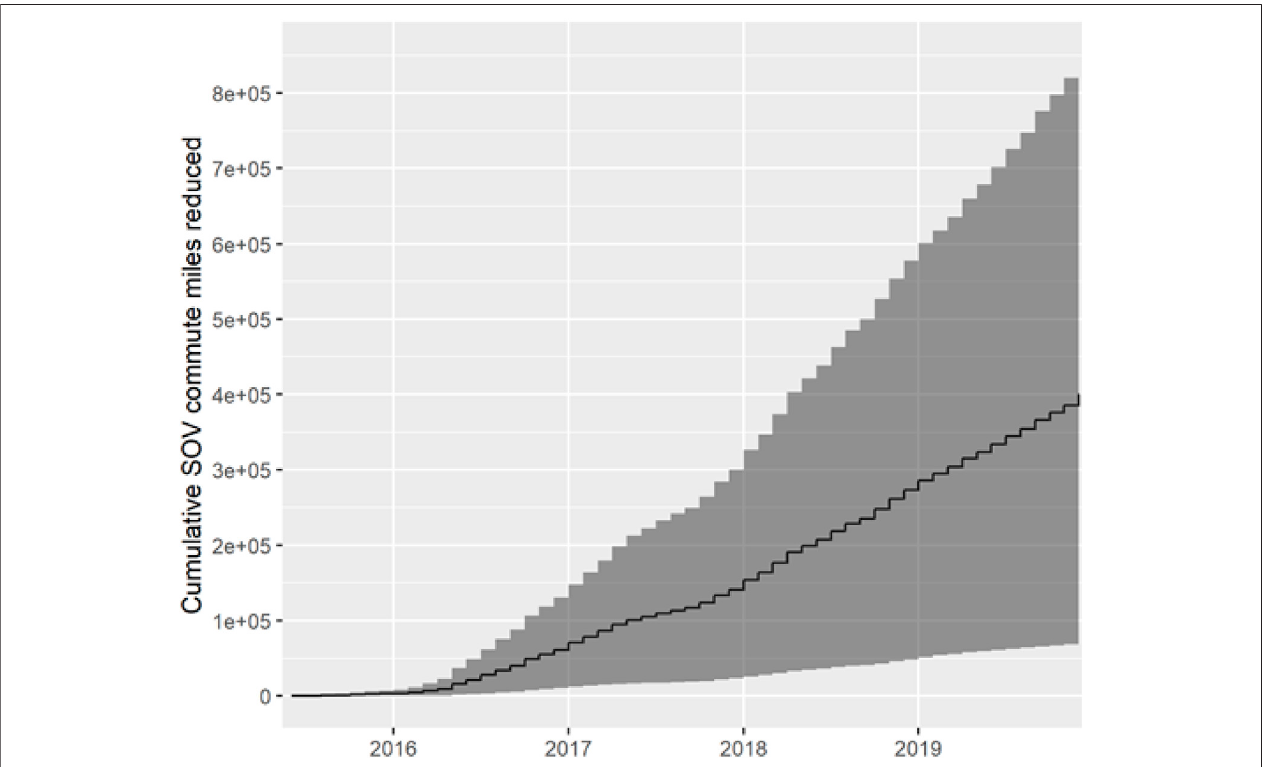
FIGURE 15 | Estimated program-level cumulative monthly SOV miles reduced based on model predicted SOV rates and self-reported number of commute days and commute distance.